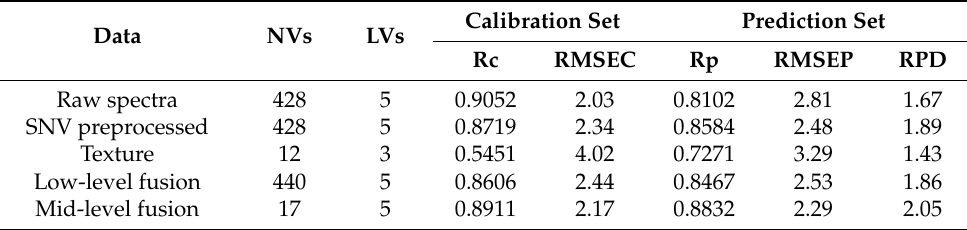
Table 2. Performance of PLSR models for starch content prediction by using different